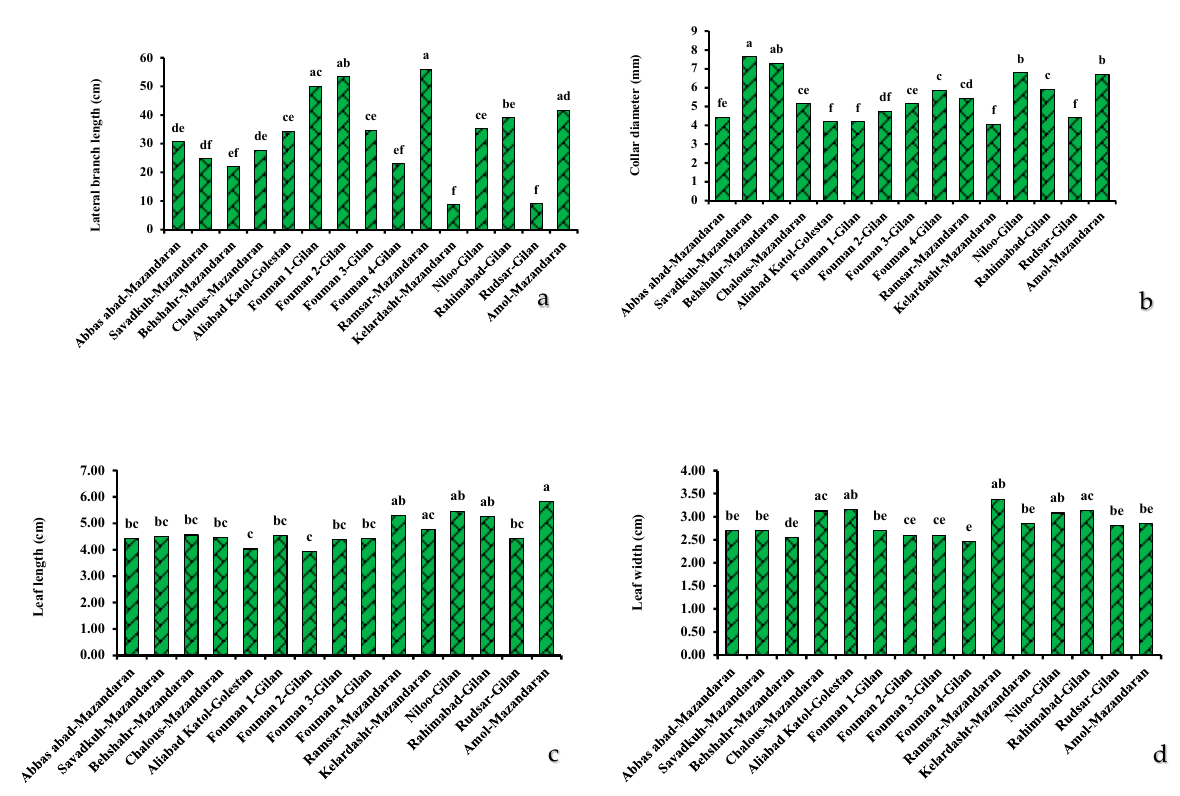
Figure 3. Mean comparison for lateral branch length ( a ), collar diameter ( b ), leaf length ( c ), and leaf width ( d ) of different ecotypes of M. aquatica collected from the Hyrcanian hotspot of Iran. Different letters indicate significant differences according to the LSD test at p < 0.05.